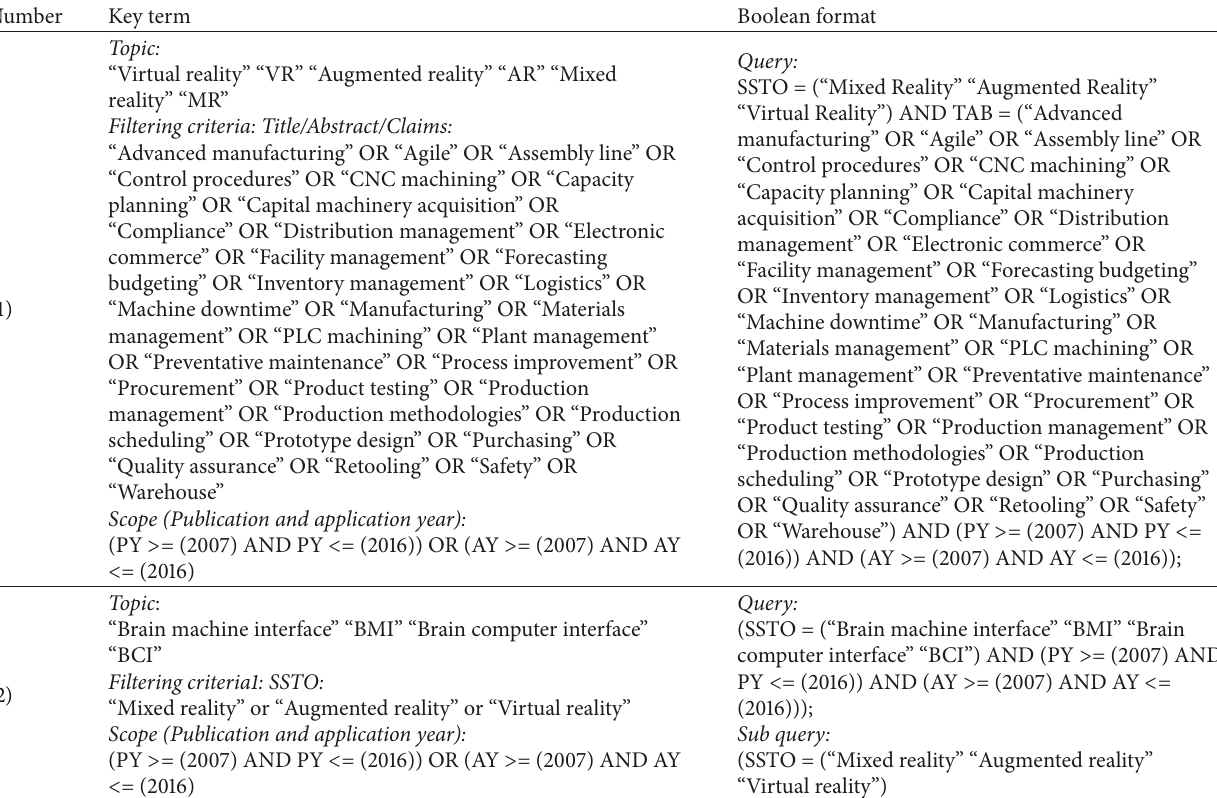
Table 3: The search query key terms.